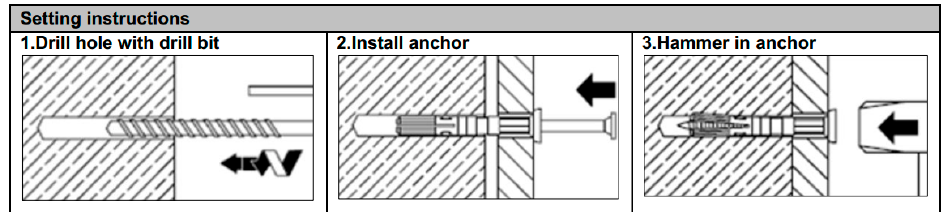
Figure 7. Procedure for installation of anchors.